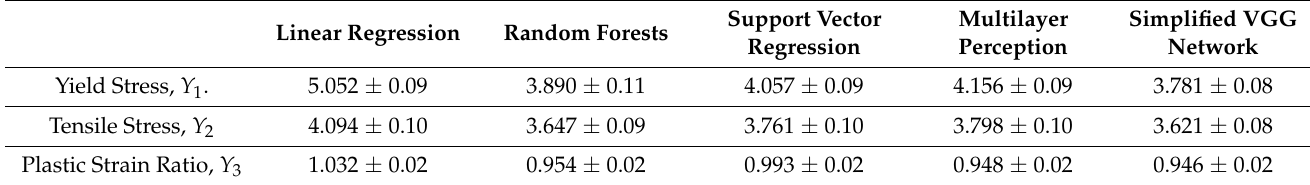
Table 3. Mean absolute errors of the five surrogate model building methods.